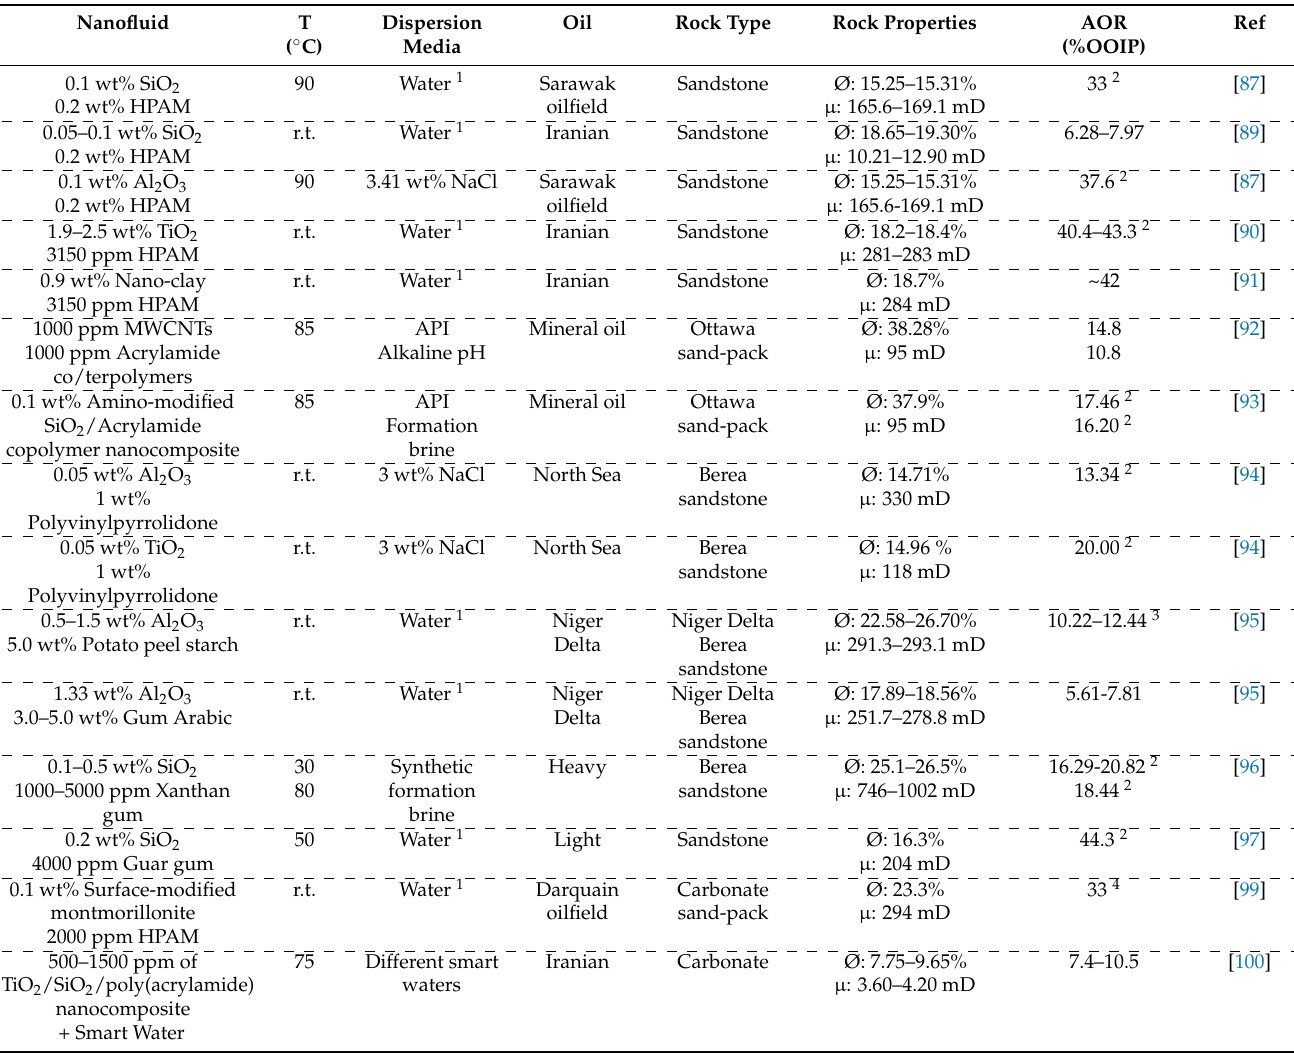
Table 5. Core-flooding tests involving nanoparticles and